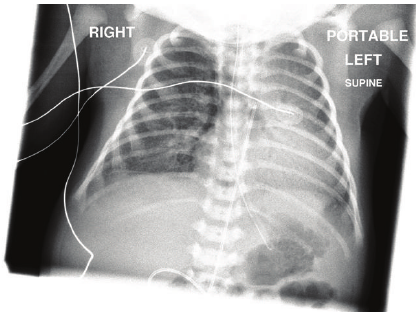
Figure 2: Frontal view of the chest demonstrates the development of multiple air-containing structures within the right lung and pneumomediastinum.